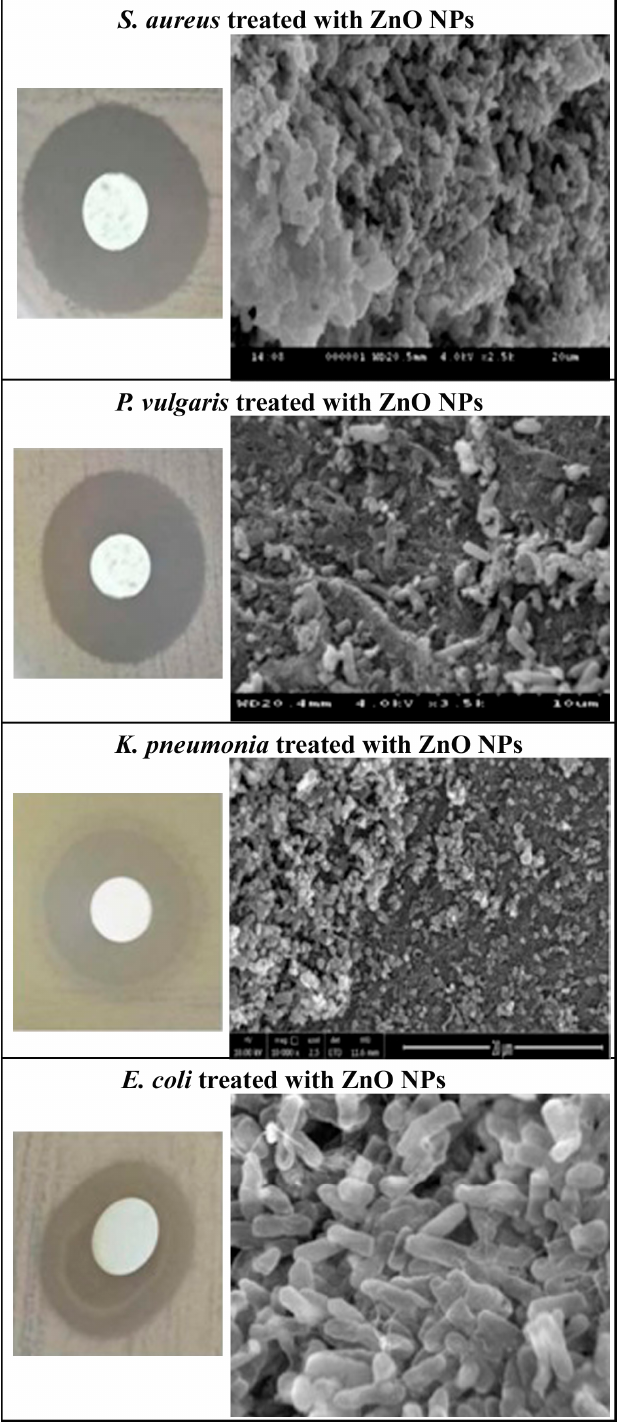
Figure 5. Zone of inhibition and SEM micrographs showing changes in morphology of Staphylococcus aureus , Proteus vulgaris , Klebsiella pneumonia, and Escherichia coli due to ZnO NPs treatments .